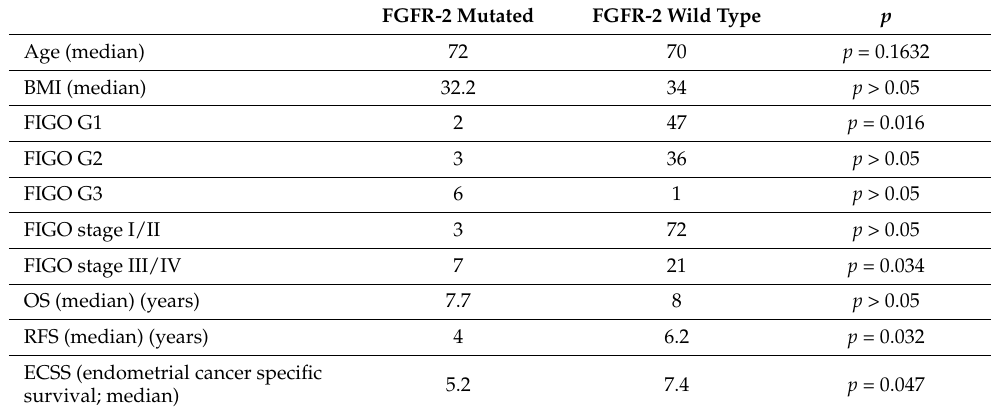
Table 3. The analysis of FGFR-2 mutation impact on grade, stage and survive.